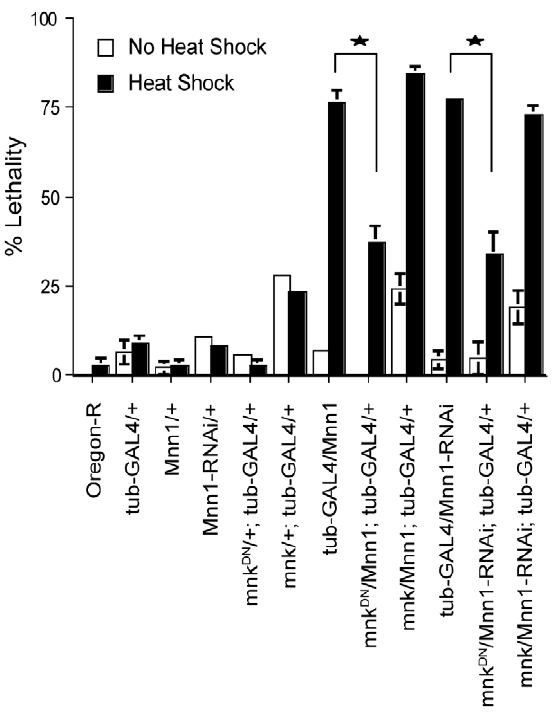
Figure 5. Menin interacts genetically with Chk2(mnk) in the heat shock response. Stage 6 to 10 embryos (3 to 5 hrs AEL) were subjected to a 1 hr heat shock treatment at 37 u C and then allowed to develop until adulthood. Mnn1 and Mnn1 - RNAi refer to strains harboring a UAS construct for the over-expression and down-regulation of menin, respectively. mnk refers to a GUS construct of Chk2(mnk) for over-expression and mnk DN refers to a strain with a GUS construct for the expression of a dominant negative Chk2(mnk) kinase. The expression of all constructs is controlled by the tub-GAL4 driver. Wild- type (Oregon-R) and parental controls ( tub - GAL4 / + , Mnn1 / + , Mnn1 - RNAi / + ) are shown for comparison. Organismal lethality observed in heat stressed Drosophila transgenic lines over-expressing ( tub-GAL4/Mnn1) or down-regulating menin by RNA i ( tub-GAL4/Mnn1-RNAi ) was attenuated by co-expression of the dominant negative mutant of Chk2 ( mnk) ( mnk DN /Mnn1; tub-GAL4/ + and mnk DN / Mnn1 - RNAi ; tub - GAL4 / + ). No significant changes in lethality were observed in transgenic strains with mis-regulated Mnn1 expression when wild-type Chk2(mnk) was over-expressed in the background ( mnk / Mnn1 ; tub - GAL4 / + and mnk / Mnn1 - RNAi ; tub - GAL4 / + ). Stars denote significant differences between the indicated strains, p ,